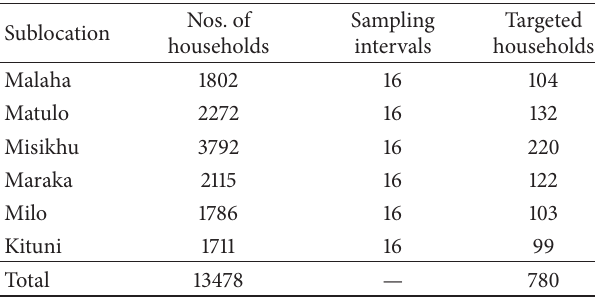
Table 1: The numbers of households allocated in each sublocation in Webuye HDSS.